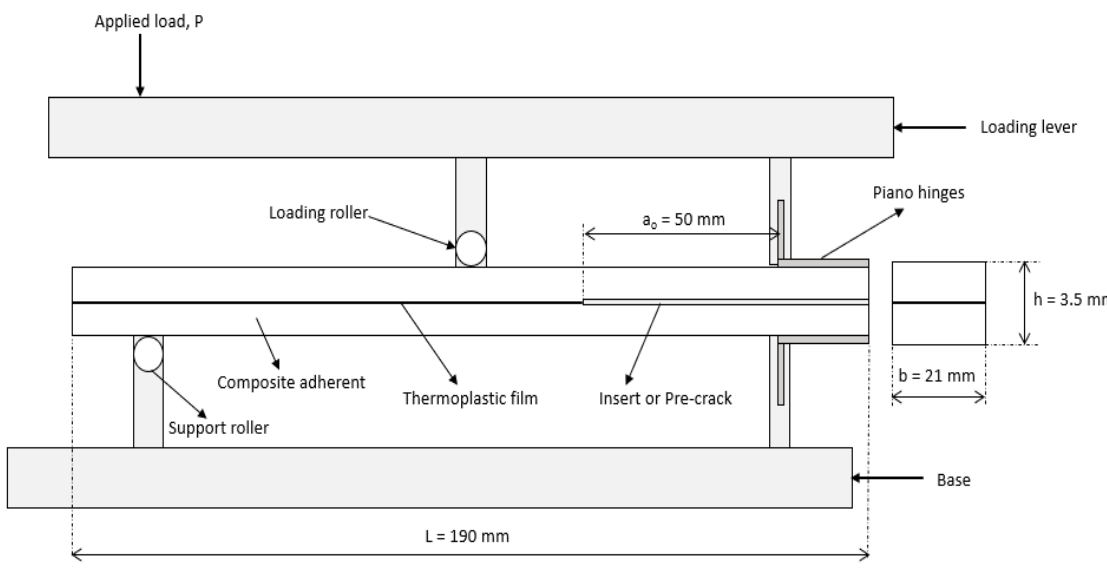
Figure 9. Schematic of MMB specimen.